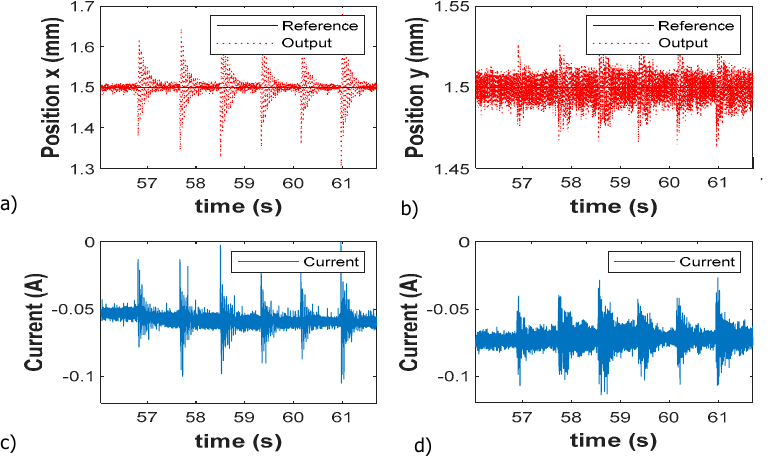
Figure 13. The AMB control current response in both x and y planes, when external disturbances are applied.